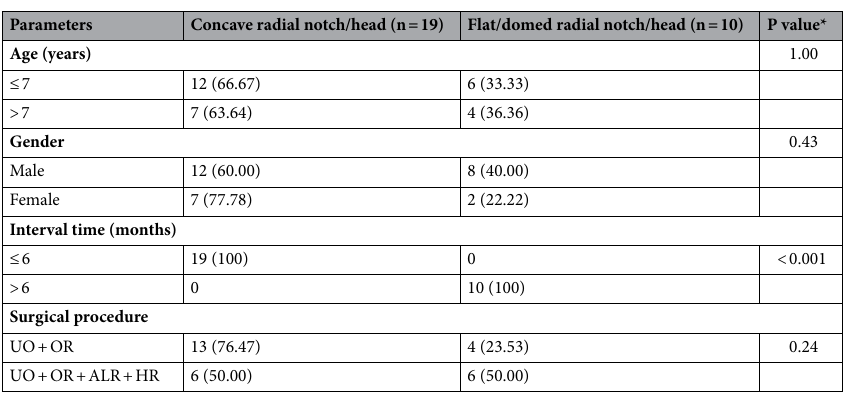
Table 3. Univariate analysis of factors that might affect the preoperative radial notch/head appearance. *Fisher’s exact test; P ≤ 0.05, statistically significant.